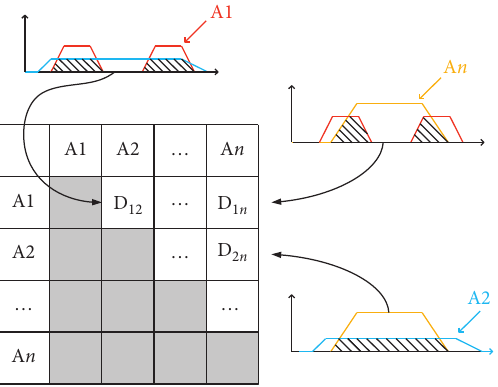
Figure 12: Similarity matrix of spatiotemporal